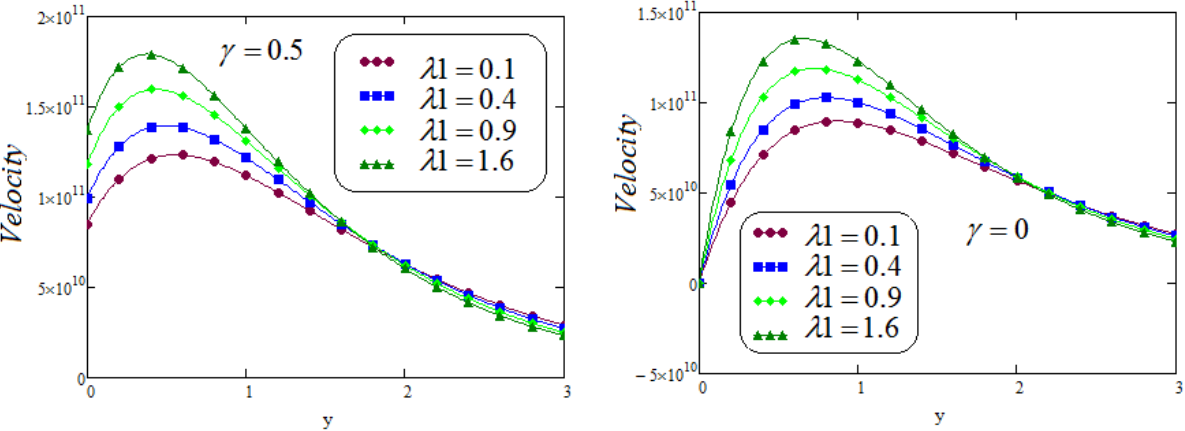
Figure 11. Velocity field under slip conditions as well as the velocity field under no-slip conditions for different λ 1 values when f ( t ) = sint , t = 1.5, Gr = 3.5, Pr = 0.71, λ 2 = 0.2, M =